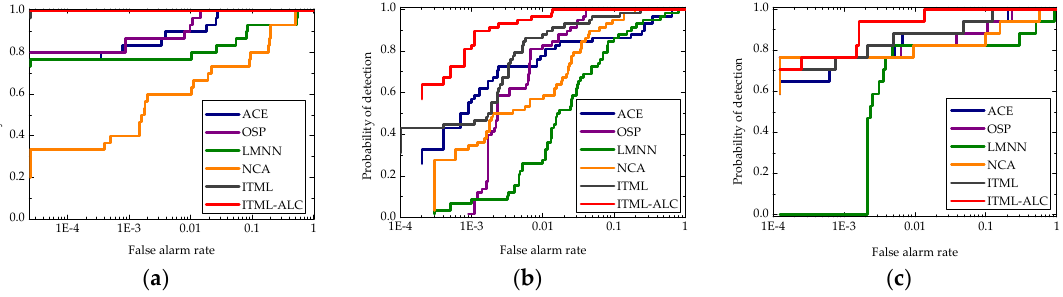
Figure 7. ROC curves of the different algorithms. ( a ) AVIRIS LCVF dataset; ( b ) AVIRIS San Diego airport dataset; ( c ) HYDICE urban dataset.